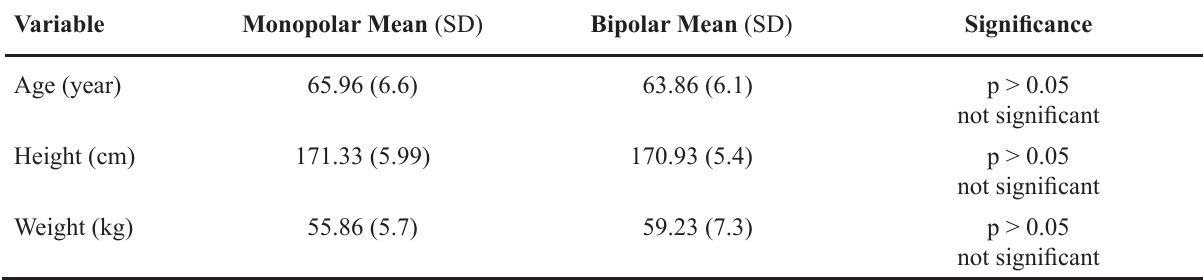
Table 1 – Age, height and weight profile.